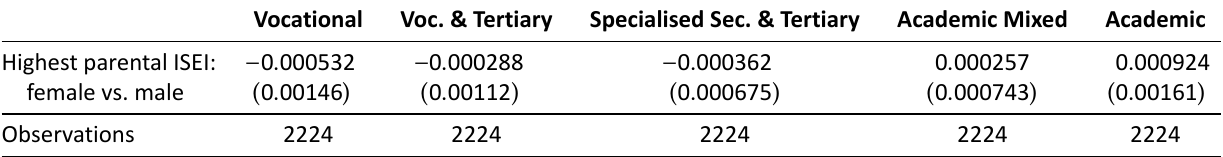
Table 5. Contrast in average marginal effect of parental ISEI (female vs.